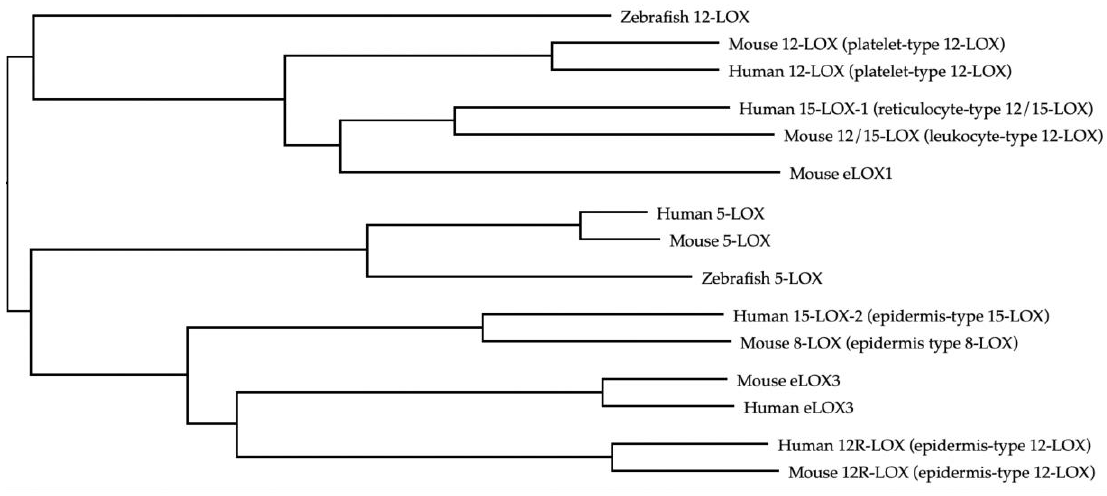
Figure 2. Lipoxygenase orthologs. Table 1. LOX-encoding genes across species.